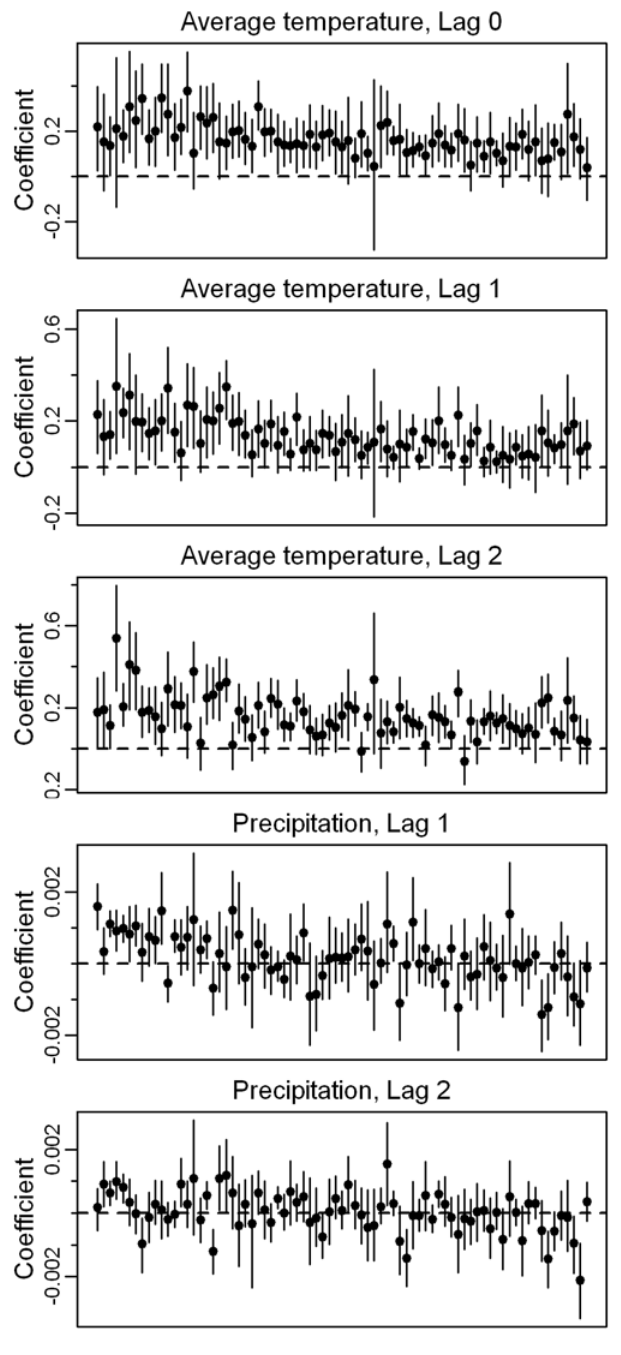
Figure 1. Local short-term associations between weather and dengue incidence. Points represent the estimated proportional increase in dengue incidence for an increase in monthly temperature (1 u C) or precipitation (1 mm) in each municipality at each lag (months). All lagged weather variables were included in the regression model simultaneously. Municipalities are ordered by mean average tempera- ture or precipitation, low to high (left to right). Black bars indicate the 95% credible interval for each estimate based on 1,000 models, one for each conditional simulation of weather data. doi:10.1371/journal.pntd.0000382.g001 (Figure 1). The global association (average short-term association